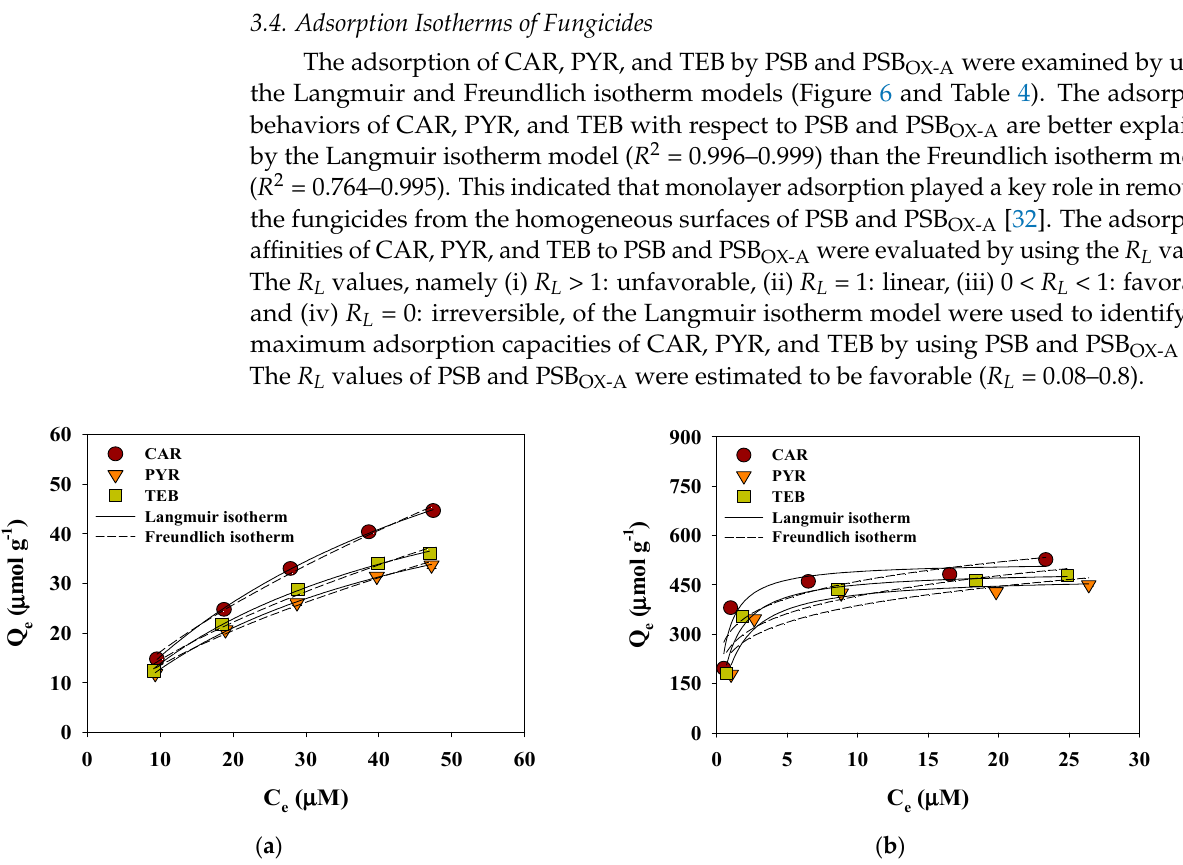
Figure 6. Adsorption isotherms of fungicides on ( a ) PSB and ( b ) PSB OX-A (agitation speed = 150 rpm; contact time = 24 h; absorbent dosage = 50 mg L − 1 ; initial concentration of each fungicide = 10 μ M; temperature = 25 °C; pH = 7.0). Table 4. Isotherm parameters for the adsorptions of fungicides using PSB and PSB OX-A (agitation speed = 150 rpm; contact time = 24 h; absorbent dosage = 50 mg L − 1 ; initial concentration of each fungicide = 10 μ M; temperature = 25 °C; pH = 7.0).